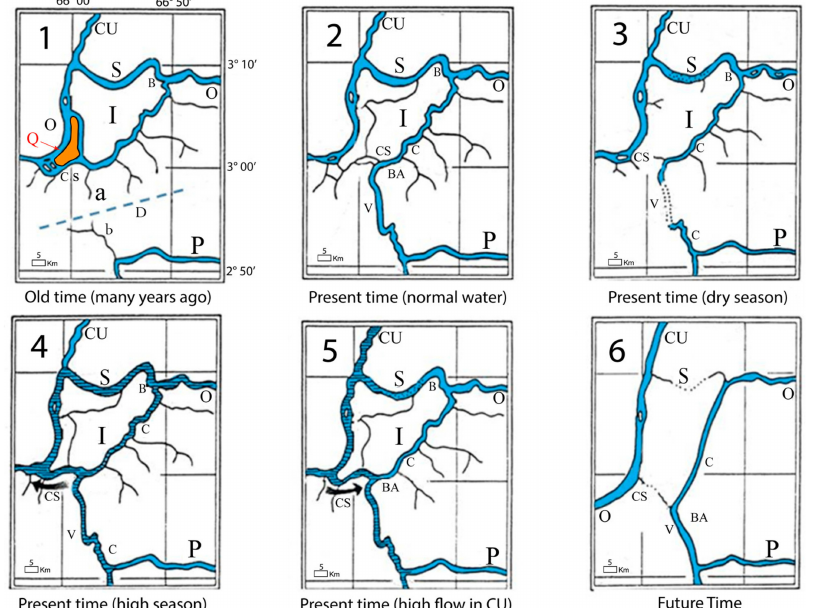
Figure 5. Sketch-maps of the Casiquiare fluvial system showing past and future trends in the evolution of the channel, according to Stern [18] as illustrated by Vareschi [19]. O = Orinoco; C = Casiquiare; CU = Cunucunuma River; B = bifurcation; I = fluvial island; CS = Caño Seco; BA = Buenos Aires sector; V = Venados (abandoned town); P = Pamoni River; S = north channel of the island; Q = Quiritari Island (in orange); D = water divide; a = small channel; b = small